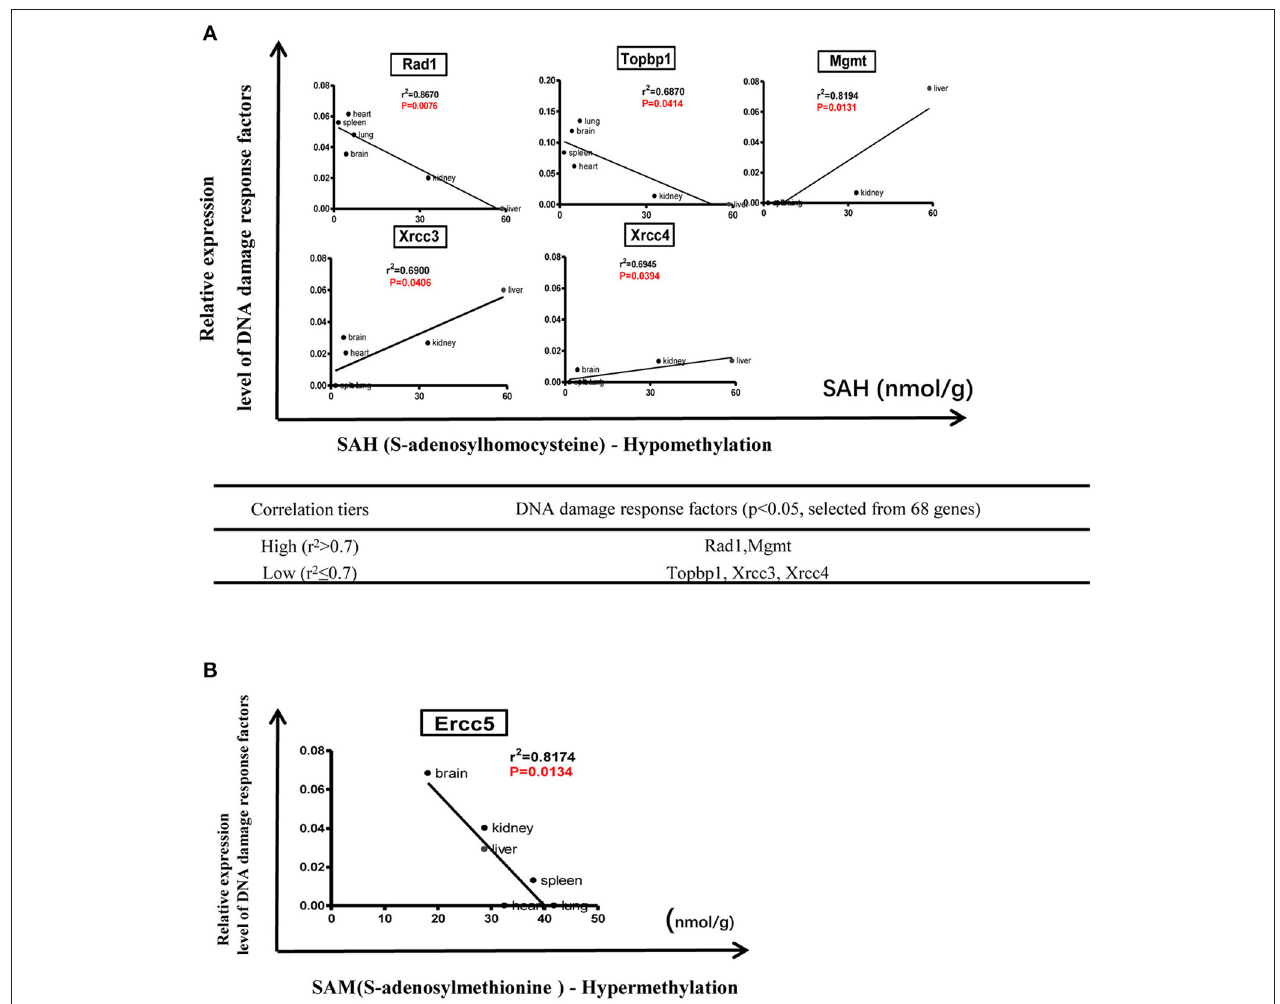
FIGURE 9 | Tissue methylation status regulated by SAM levels modulate DNA damage response. (A) Correlation between DNA damage response factors and hypomethylation status. (B) Correlation between DNA damage response factors and hypermethylation